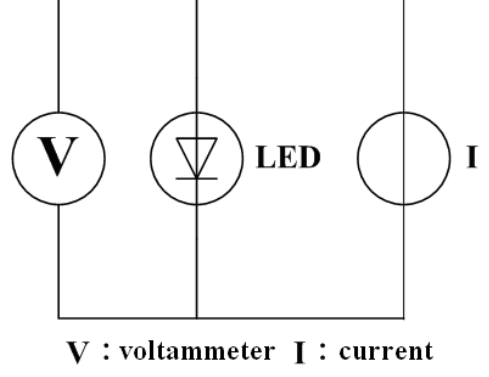
Figure 1. Circuit illustration of thermal resistance measurement technology.